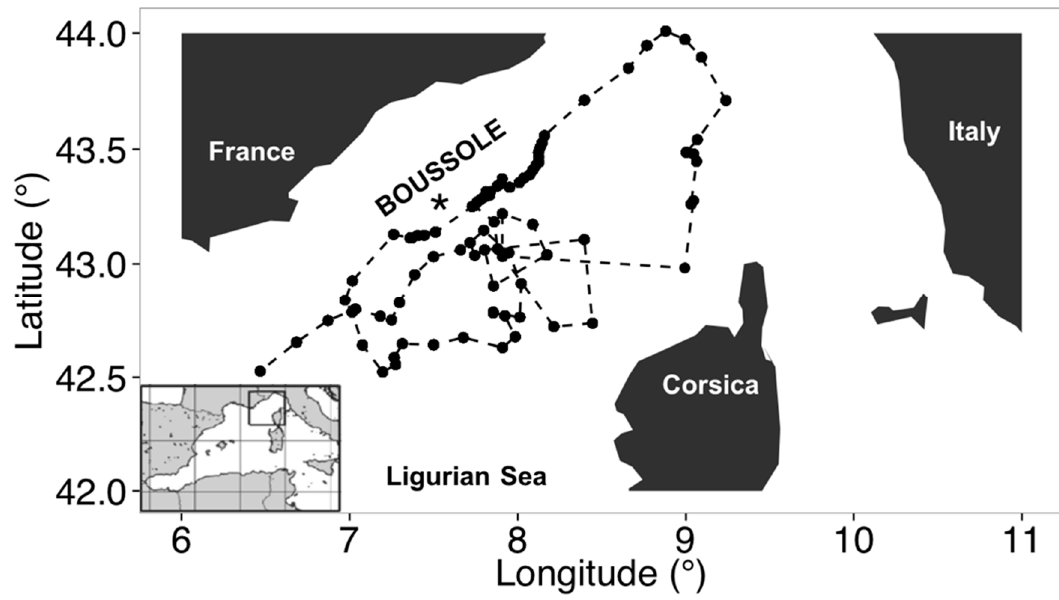
Figure 1. The northwestern Mediterranean Sea showing the southern coast of France, the island of Corsica, and the location of the BOUSSOLE buoy in the Ligurian Sea (black star) redrawn from [22]. Black dots are the locations where the float surfaced, while the float trajectory is overlaid in the plot with dashed black line.